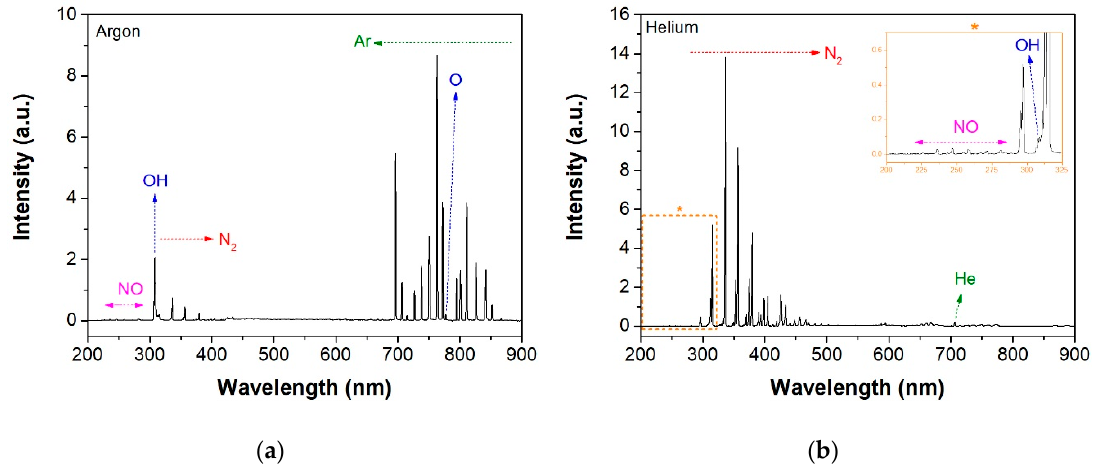
Figure 4. Optical emission spectra of the discharges generated in ( a ) argon and ( b ) helium.